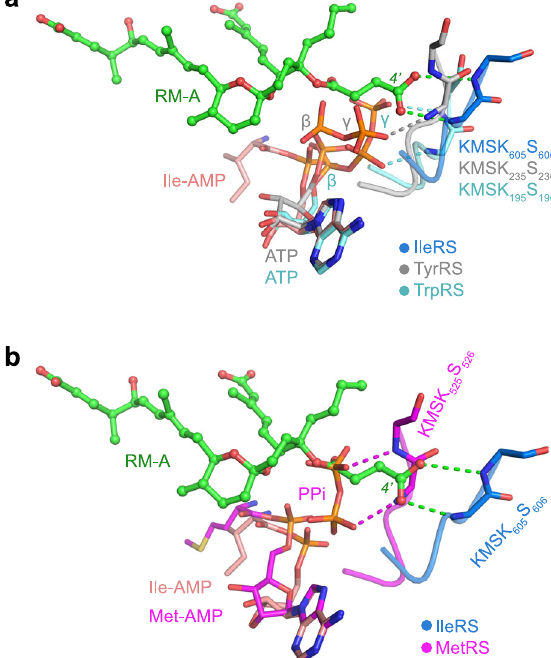
Fig. 4 The C18 hemisuccinate of RM-A uses its terminal carboxyl group to mimic the phosphate groups of ATP for IleRS binding. a Structural superposition of the T. thermophilus TyrRS ∙ ATP complex (grey, PDB ID: 1H3E) and Bacillus stearothermophilus TrpRS ∙ ATP complex (cyan, PDB ID: 1M83) with the Sc IleRS ∙ RM-A ∙ Ile-AMP complex (blue). The backbones of the KMSKS loop form H-bonds with the C4 ’ carboxyl group of RM-A (indicated as green dashed lines), and they also form similar H-bonds with the β - or γ -phosphates of ATP in ATP-bound TyrRS and TrpRS structures (indicated as grey and cyan dashed lines, respectively). b Structural superposition of the Leishmania major MetRS ∙ Met-AMP ∙ PPi ternary complex (magenta, PDB ID: 3KFL) with the Sc IleRS ∙ RM-A ∙ Ile-AMP complex. The H-bonds between the backbones of the KMKSK loop and PPi are indicated as magenta dashed lines.